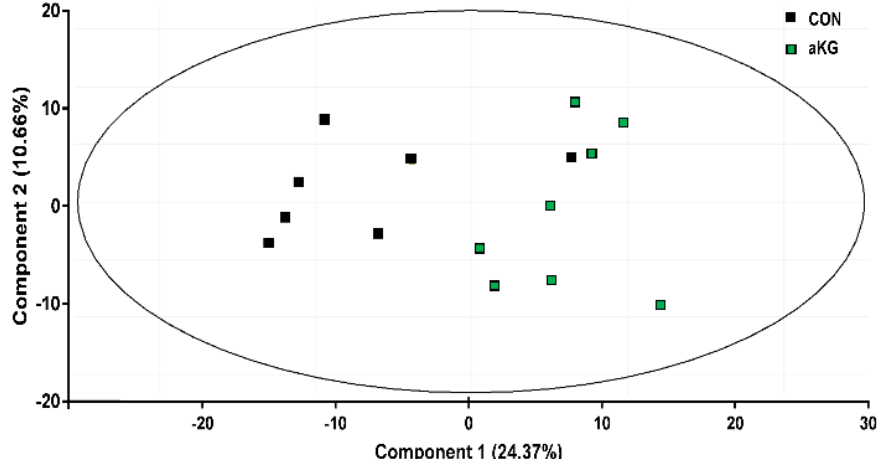
Figure 1. PCA of the cecal metabolome of dextran sulfate sodium (DSS)-induced colitis mice receiving water with or without alpha-ketoglutarate (aKG). CON: control mice without aKG supplementation in drinking water; aKG: mice receiving 1% aKG. n = 7–8 mice per group.